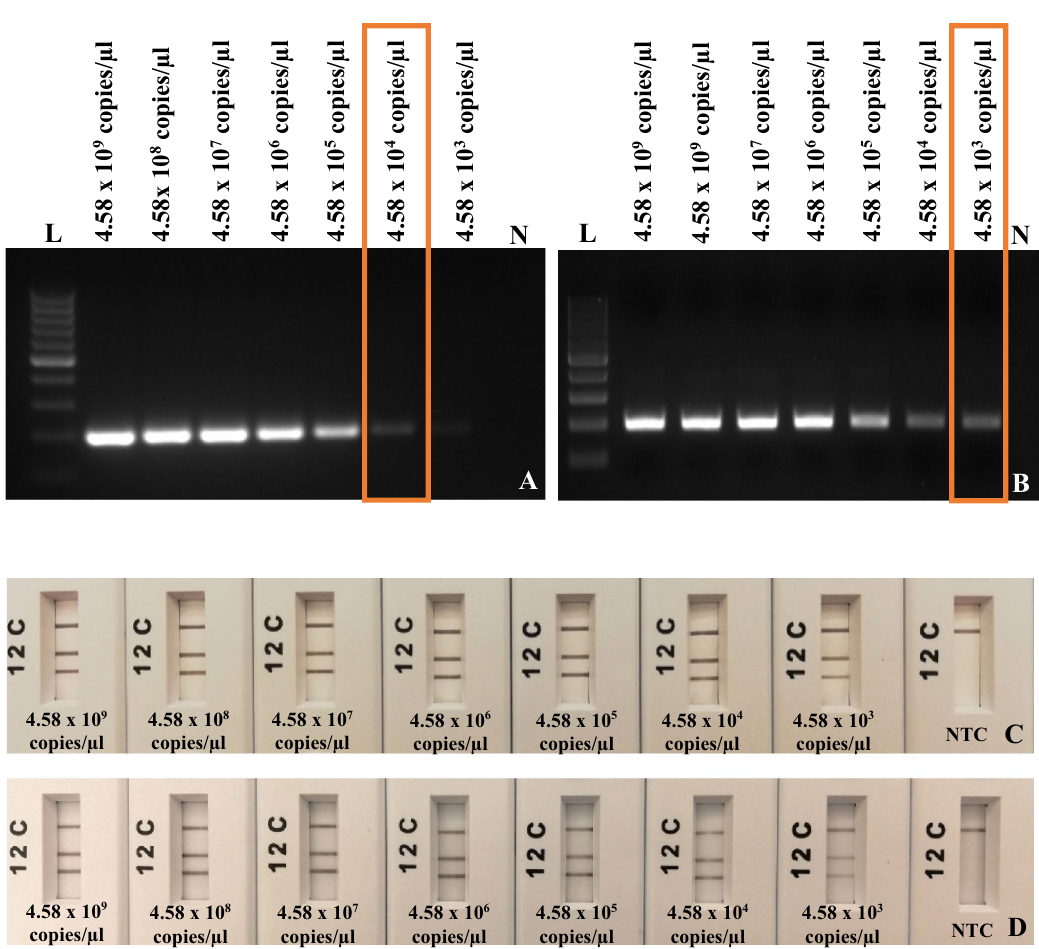
Figure 4. Limit of detection assays of A. phagocytophilum . ( A ) RPA-basic primers using ten-fold serial dilution of A. phagocytophilum plasmid from 4.58 × 10 9 to 4.58 × 10 3 copies/µl. ( B ) RPA-basic primers using ten-fold serial dilution of A. phagocytophilum total DNA from 4.58 × 10 9 to 4.58 × 10 3 copies/µl. Lane N, non-template control (NTC, water); lane L, 100 bp DNA ladder. ( C ) Multiplex RPA- nfo primers and probe using ten-fold serial dilution of Artificial Positive Control (APC). ( D ) Multiplex RPA- nfo primers and probe using ten-fold serial dilution of A. phagocytophilum total DNA from 4.58 × 10 9 to 4.58 × 10 3 copies/µl. Lane C, flow-check line; Lane 2, detects FAM/Biotin labelled amplicons ( A. phagocytophilum ); Lane 1, detects DIG/Biotin labelled amplicons (GAPDH—internal control); Lane N, non-template control